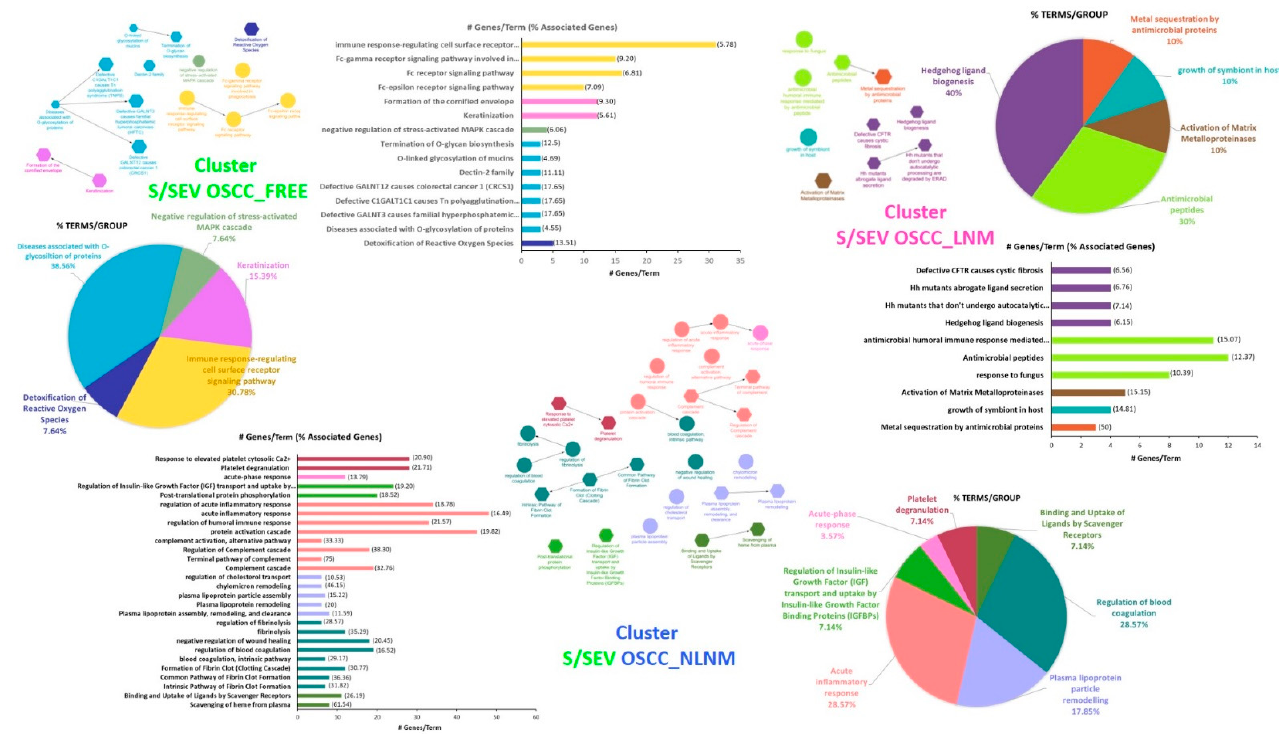
Figure 6. Graphical representation of data obtained by ClueGo analysis. For each S/SEV OSCC cluster, the number of genes/term and the number of terms/functional GO are reported. Table 5. Proteins specifically up-represented in S/SEV OSCC_FREE.